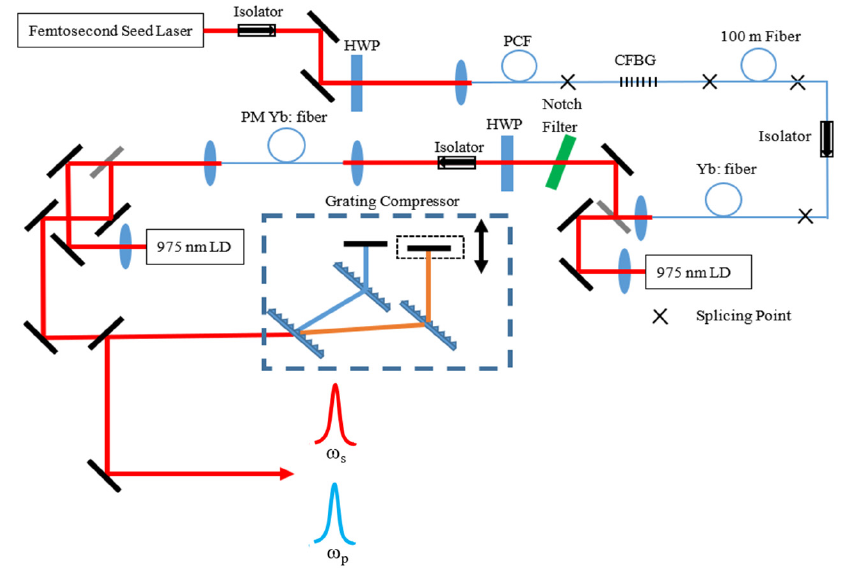
Figure 9. The dual-wavelength CPA system built by Donna Strickland’s group. A femtosecond laser system delivers 200 fs, 400 mW average power, and 65 MHz repetition rate laser pulses. The laser is then coupled into a photonic crystal fiber to achieve supercontinuum generation ranging from 900 to 1100 nm. A chirped fiber Bragg grating (CFBG) blocking the transmission from 1025 to 1085 nm is used to select the dual-wavelength seed source. Finally, the dual-wavelength seed source enters the CPA system to achieve final amplification with a total average power of 2.3 W (1.9 W at 1025 nm and 0.4 W at 1085 nm). The full width at half-maximum (FWHM) duration of the final compressed output pulses of each color are 900 fs and 600 fs, respectively.